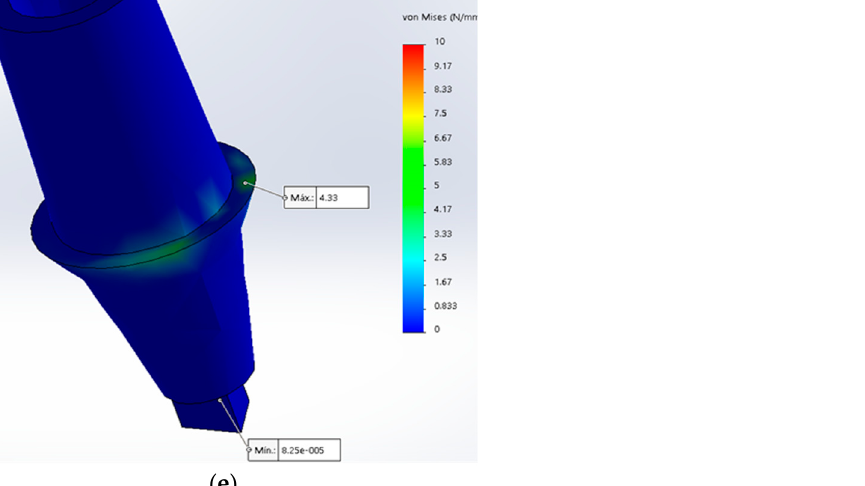
Figure A3. Maximun stress in the abutment with 150 N: ( a ) External hexagon; ( b ) internal hexagon; ( c ) morse taper; ( d ) conical connection; ( e ) conical triangular connection.